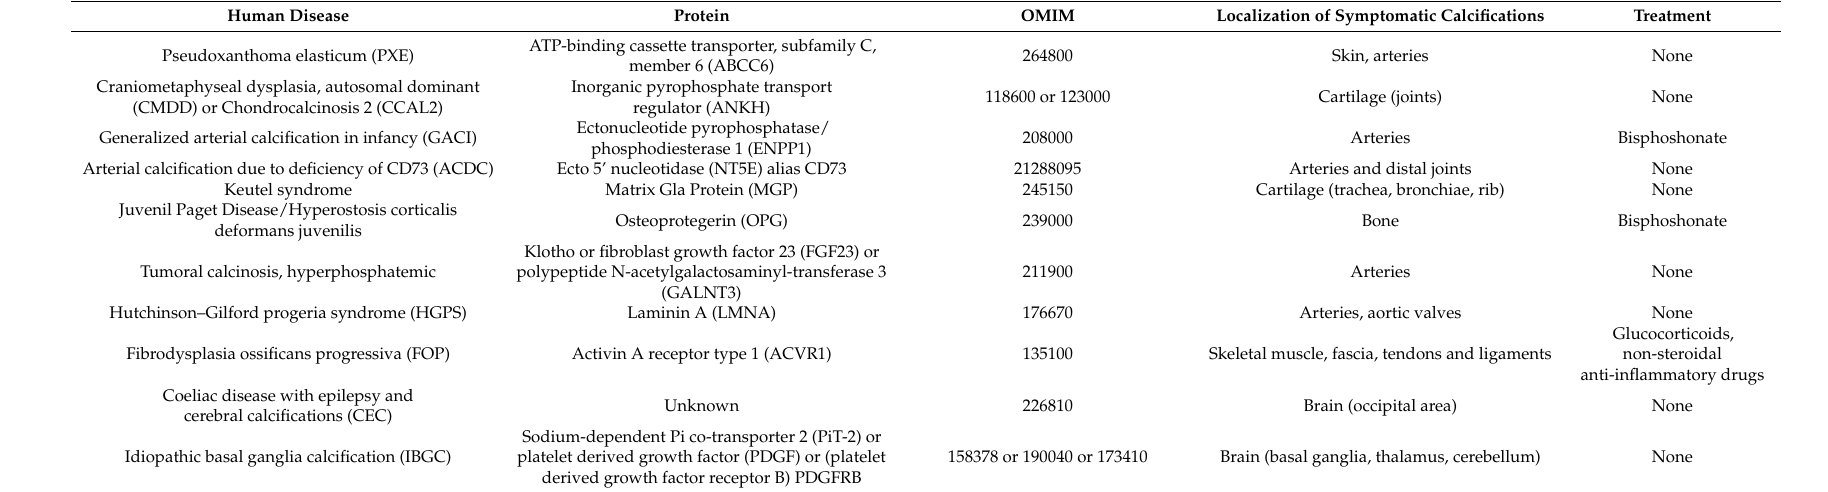
Table 2. Overview of genetic calcifying